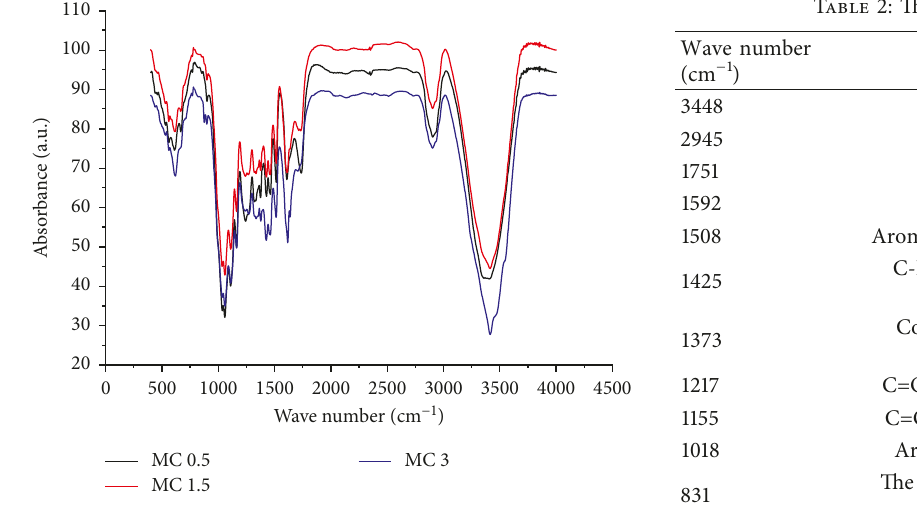
Figure 1: The FTIR spectra of specimens with various initial MC levels and heat treated at 200 ° C: MC 0.5, MC 1.5, and MC 3 were 5%, 15%, and 30% MC, respectively.